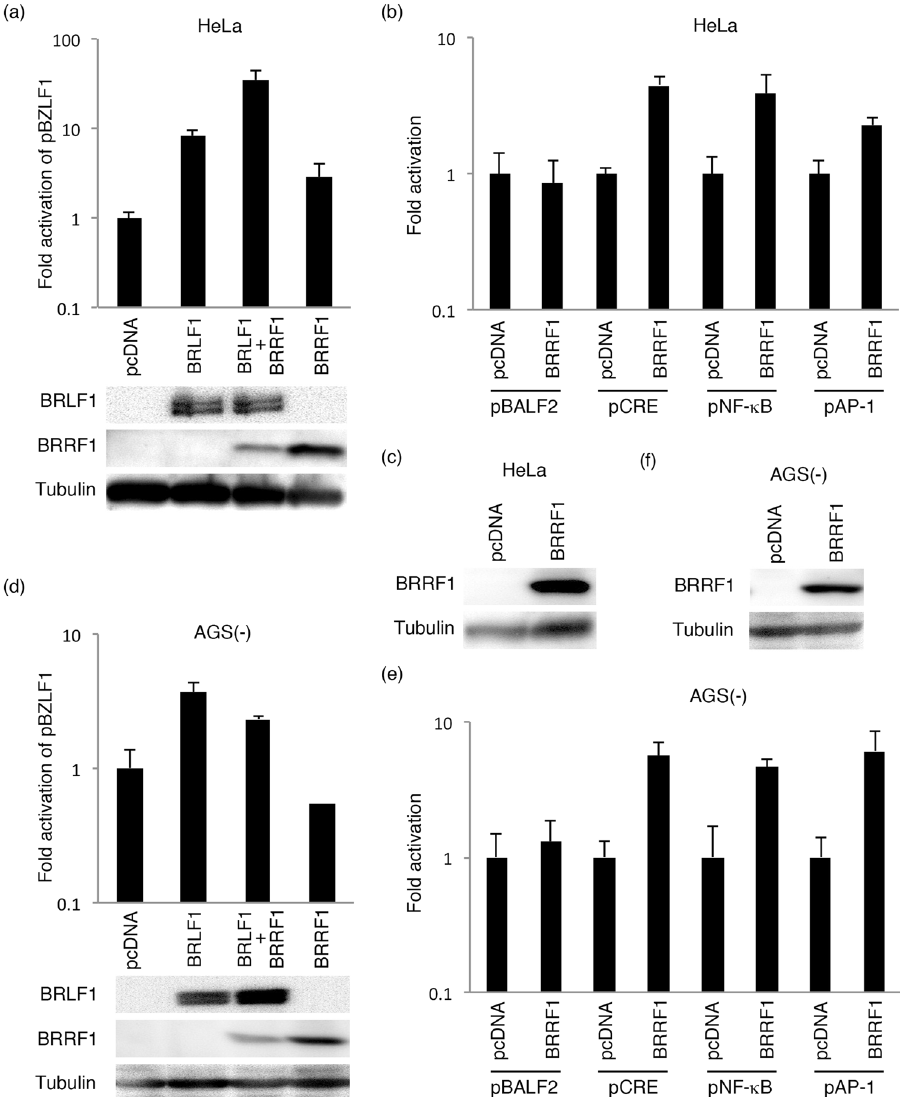
Figure 6. Evaluation of promoter activity. The indicated expression vectors were transfected by lipofection into HeLa ( a , b , c ) or AGS(-) ( d , e , f ) cells, along with pBZLF1-FL ( a , d ) or each reporter plasmid (pBALF2-FL, pCRE-FL, pNF- κ B-FL and pAP1-FL) ( b , e ) and null-RL. Cells were collected after 24 hours and subjected to luciferase assays. FL activity was normalized to RL, and the values for the cells transfected with the empty vector (pcDNA3) were set to 1. ( a , c , d , f ) Cell lysates were subjected to immunoblotting, and a representative result is presented. Original blots are presented in Supplementary Figures